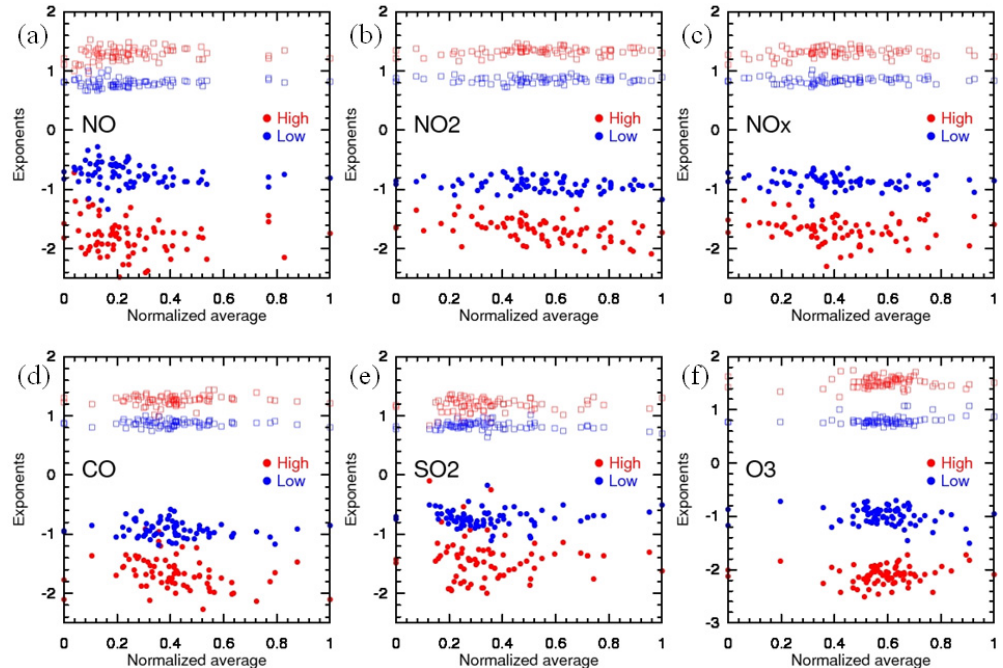
Fig. 6. The relationships between exponents and normalized averages for NO (panel a ), NO 2 (panel b ), NO x (panel c ), CO (panel d ), SO 2 (panel e ), and O 3 (panel f ), respectively. Exponents from high- and low-frequency bands (HFB (red dots) and LFB (blue dots)) of CWT spectra and those from small and large time-lag bands (STLB (red squares) and LTLB (blue squares)) of DFA are presented separately for each gas.